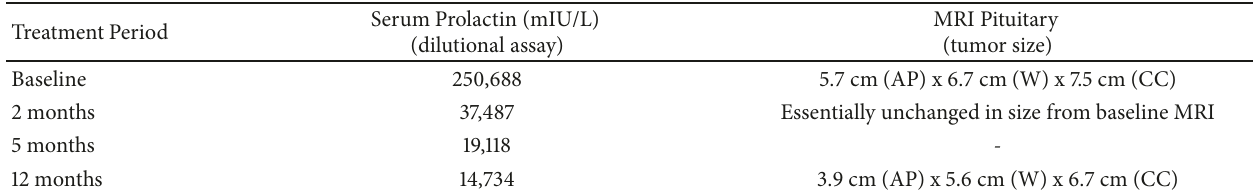
Table 1: Summary of disease progression with